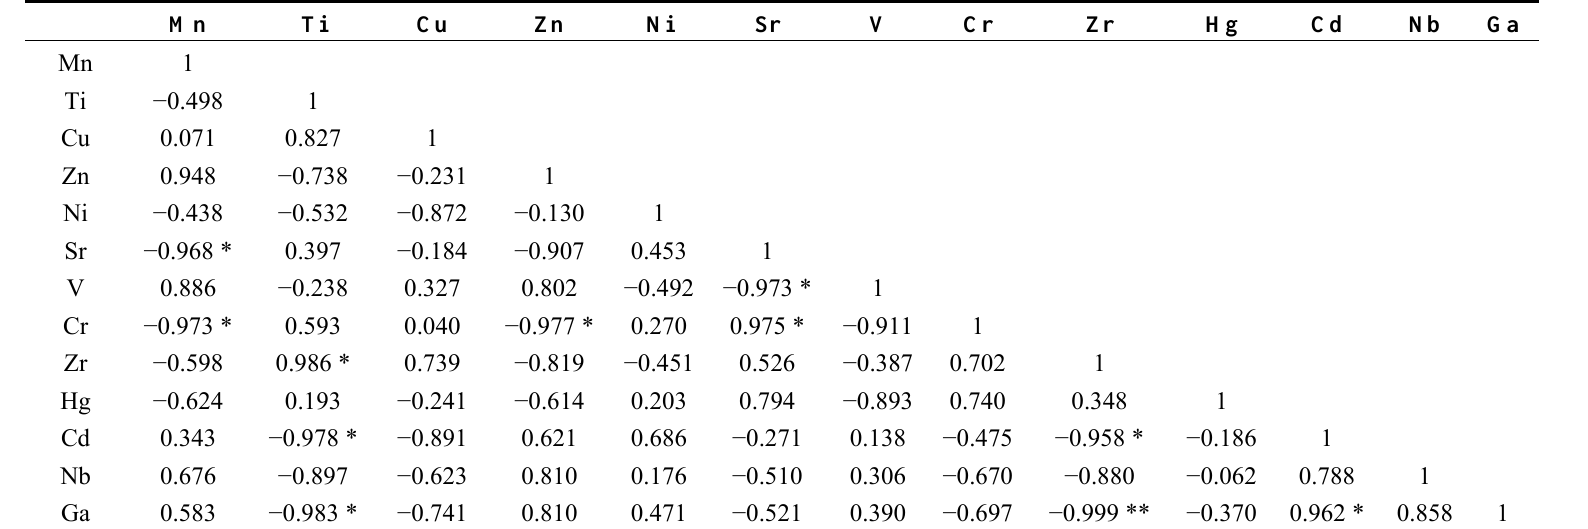
Table 3. Correlation coefficient matrix of heavy metals in